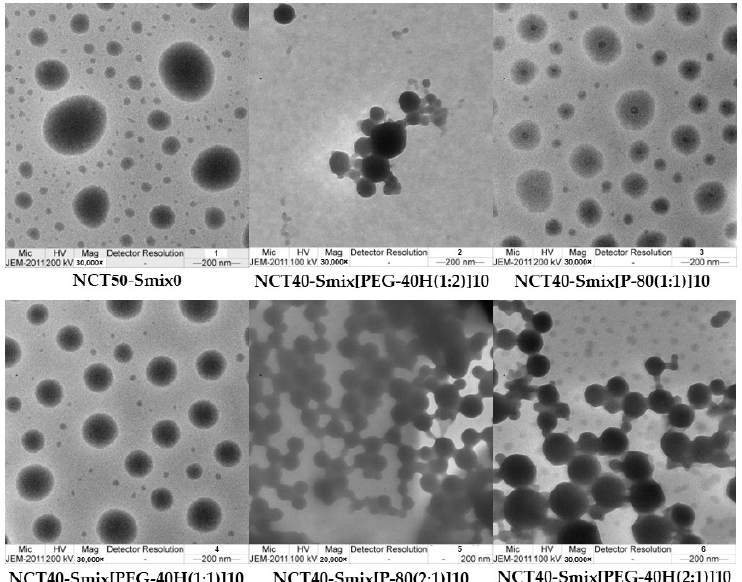
Figure 1. TEM images of NCT 50- Smix 0 and selected NCT-ME after 100-fold dilution with water; scale bar: 200 nm.